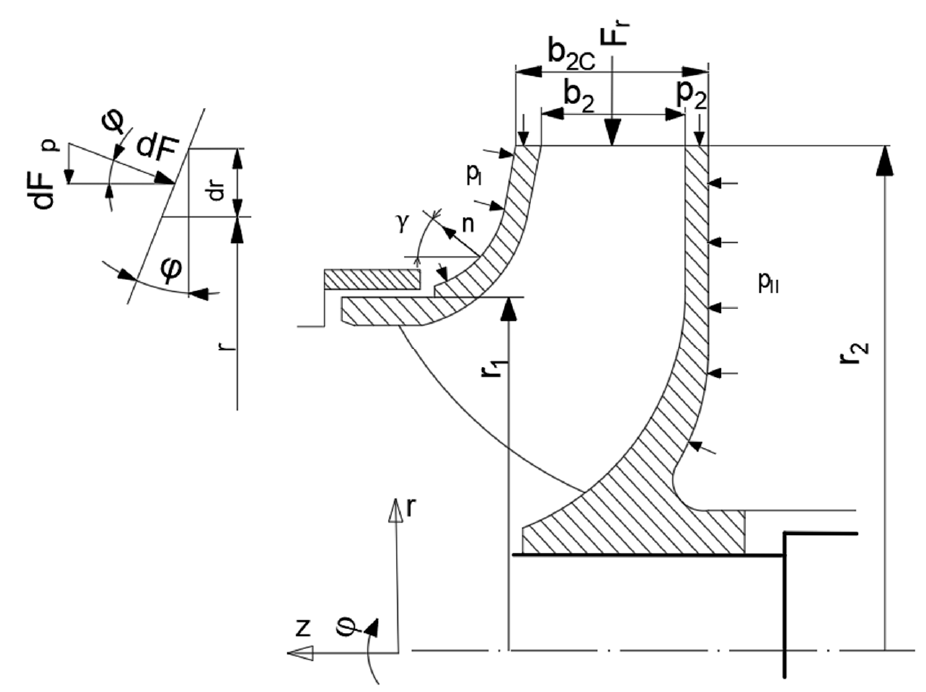
Figure 1. Pressures and force acting on rotor outside surfaces [9] .